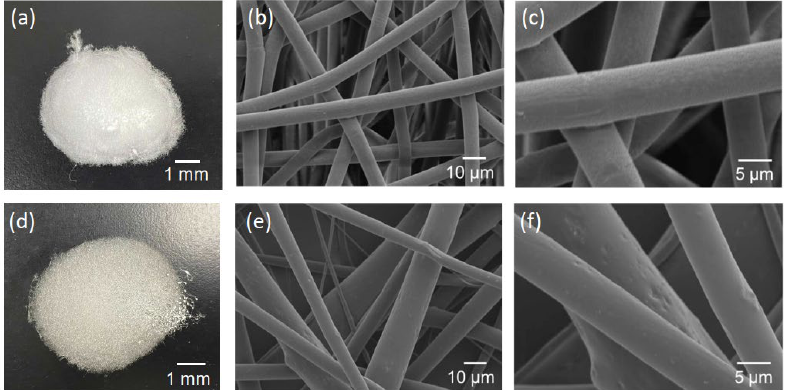
Figure 5. Pictures (left column) and SEM micrographs (middle and right columns) of the ( a – c ) polymer and ( d – f ) composite samples.